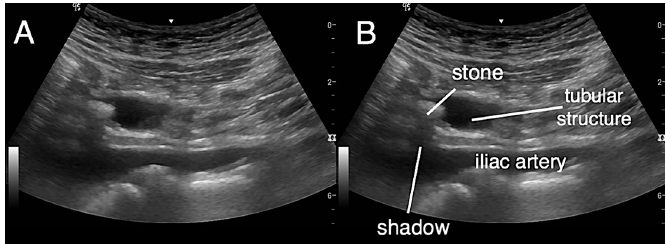
Image 2. Ultrasound right lower quadrant, long axis, curvilinear probe. A hyperechoic circular focus with acoustic shadowing is noted within a hypoechoic, non-peristalsing, non-compressible, tubular structure superior to the iliac vessels. A ureteral stone is identified as a hyperechoic structure, which demonstrates acoustic shadowing within the dilated